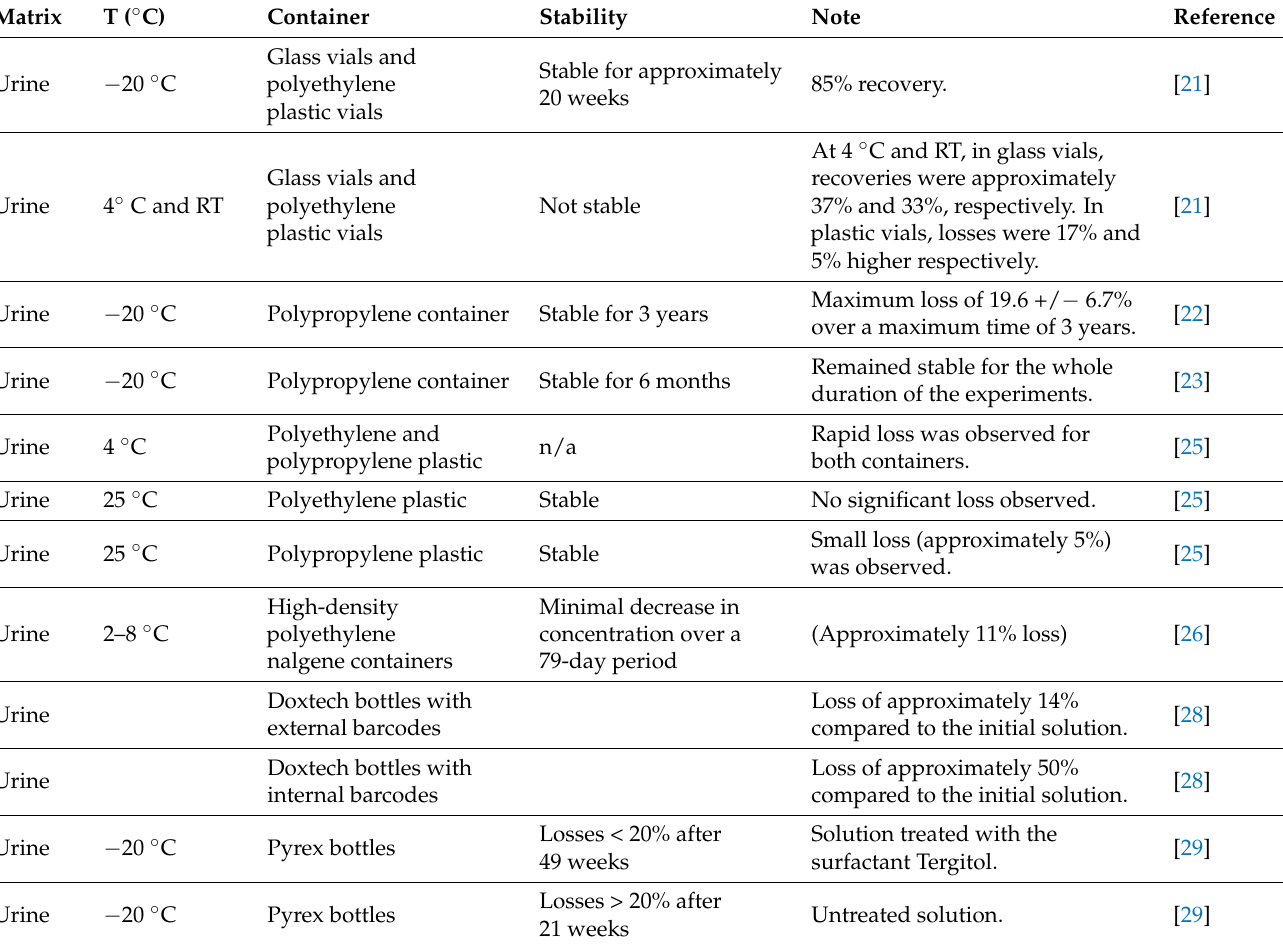
Table 3. Duration of storage stability for cannabinoids in urine based on temperature and collec- tion